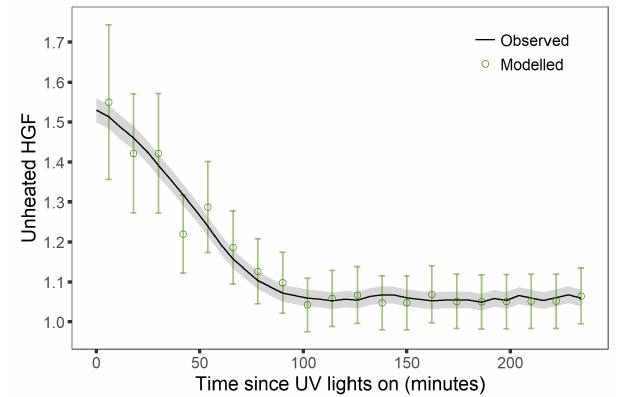
Figure 7. Observed and predicted hygroscopicity of unheated, in- ternally mixed α -Pinene SOA and AS aerosol during 4h of SOA formation. The shaded region shows ± 2% uncertainty in H-SMPS measurements, while error bars represent composition-dependent uncertainties for this